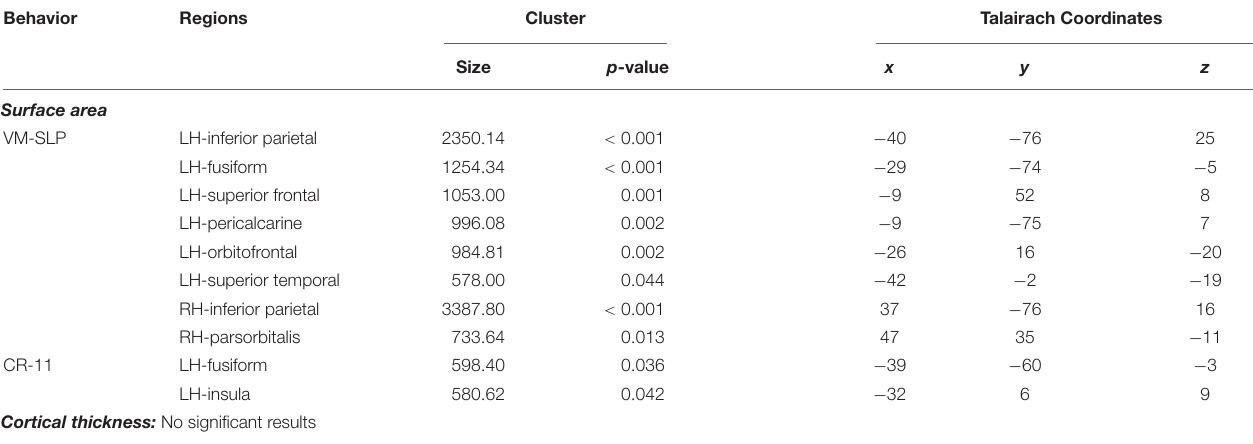
FIGURE 1 | Significant clusters in the vertex-wise whole-brain analyses (Monte Carlo procedure for correction of multiple comparisons, 10000 iterations, vertex- p < 0.01, cluster- p < 0.05; red = positive correlation, blue = negative correlation). (A) Surface areas in eight clusters were positively correlated with the growth rate of Visual Matching (VM-SLP), while age and sex were statistically controlled. (B) Surface areas in two clusters were positively correlated with children’s character reading at Grade 5 (CR-11), while age and sex were statistically controlled. TABLE 3 | Results of a whole brain vertex-wise analysis after correction for multiple comparisons using a cluster-based Monte Carlo procedure (10000 iterations; vertex- p < 0.01, cluster- p < 0.05) from the subsample of 79 participants. Behavior Regions Cluster Talairach